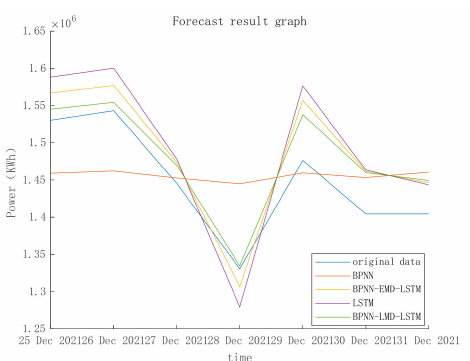
Figure 13. BPNN–LMD–LSTM hybrid model, BPNN, LSTM, and BPNN–EMD–LSTM compari- son chart.